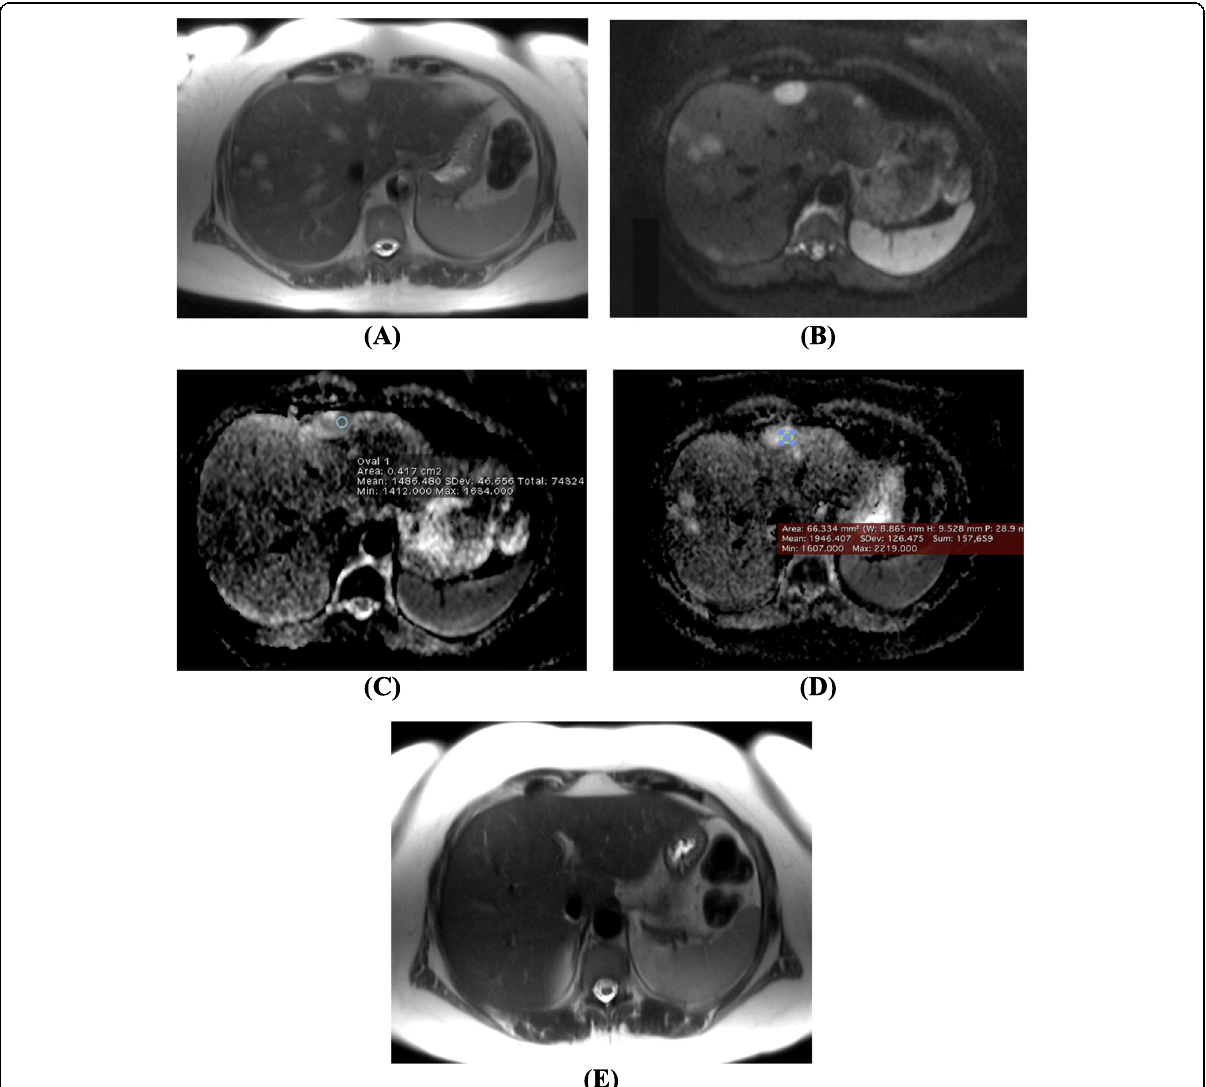
Fig. 4 Case (1): A 48 year old female patient with history of rectal adeno-carcinoma with hepatic metastasis, patient has contrast sensitivity and only non-contrast MRI was done. a ) Base line pre chemotherapy axial T2 MRI revealed; multiple lesions, the target lesion is a well-defined sub capsular hyper intense lesion measuring about 2.5cm seen in segment III. b ) Corresponding axial baseline diffusion weighted image of the previous T2 target lesion with b Value of (800 m2/sec) shows the lesion displaying hyper intense signal. c ) pre therapeutic ADC image revealed diffusion restriction and ADC value of 1.49 x10-3 m2/sec ( d ) post therapeutic (21 days after chemotherapy) ADC map showing increase in